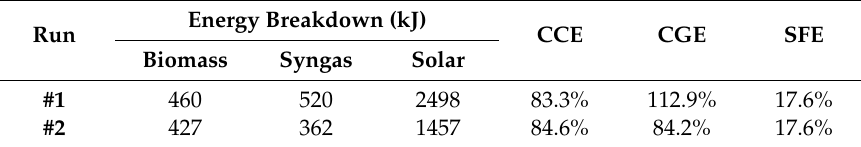
Table 4. Performance metrics for beechwood